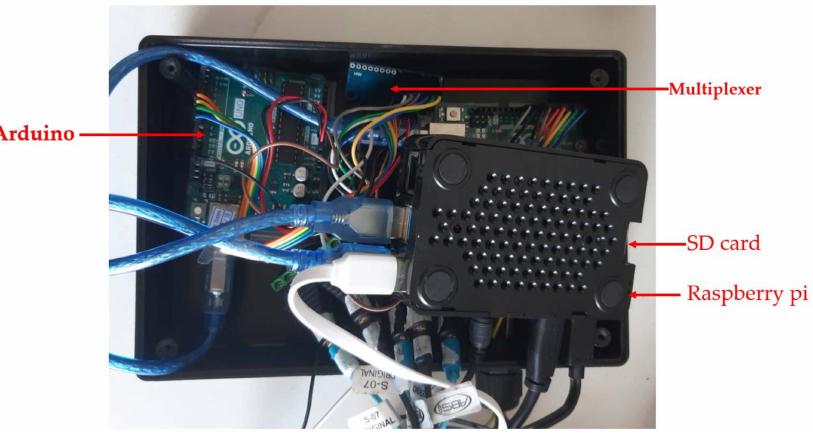
Figure 5. Sample devices inside control box.